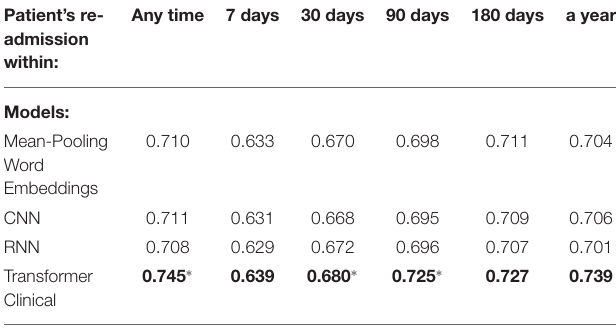
TABLE 6 | Comparison of the deep neural models on a randomly chosen 512-token sub-sequence of discharge summaries for the re-admission prediction targets.